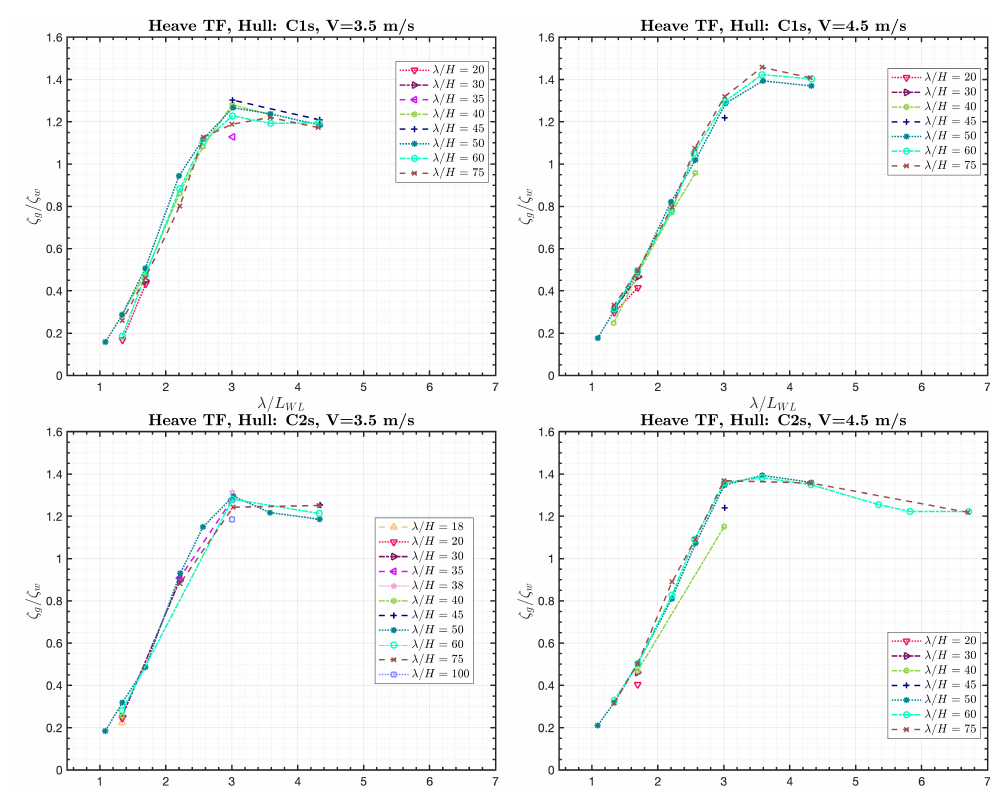
Figure 7. Heave response vs. λ / L WL